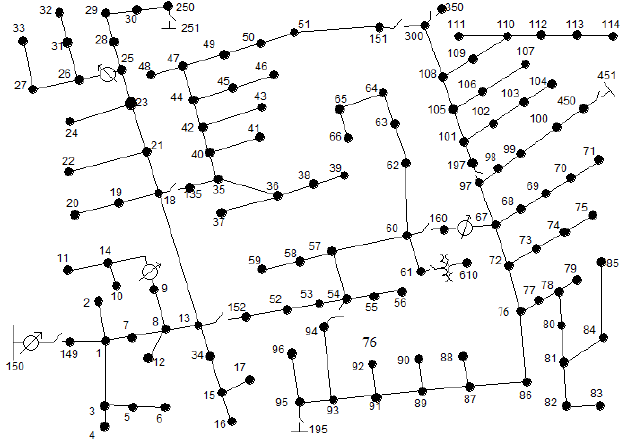
Figure 5. Institute of electrical and electronics engineers (IEEE) 123-bus test feeder. Position of switches is set for a radial configuration.